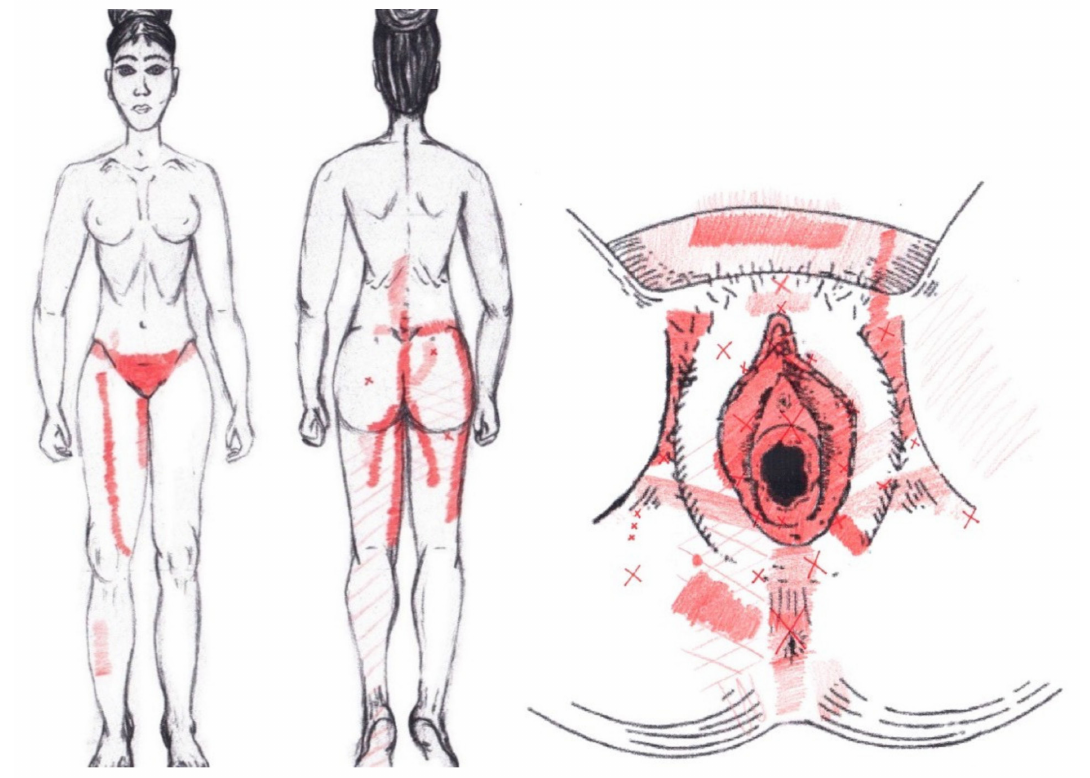
Figure 16. Graphical simulation of referred pain areas of the pubococcygeus muscle.